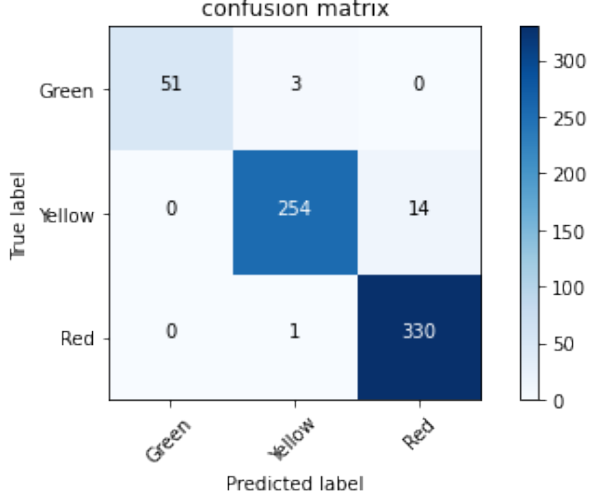
Figure 12. KNN confusion matrix on San Lorenzo test case.